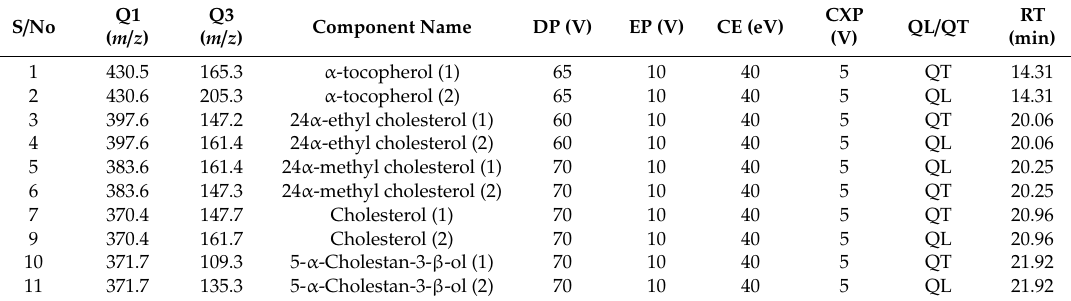
QL: Qualitative, QT: Quantitative, RT: Retention